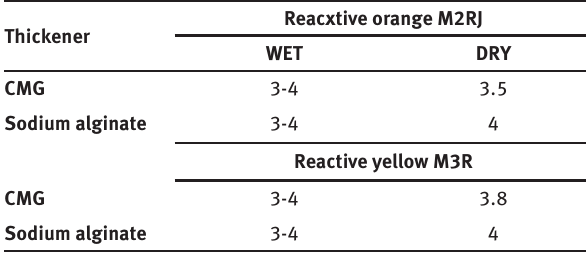
Figure 4: Comparison of CMG thickener with sodium alginate. Table 3: Parameters showing color fastness to crocking for diffe- rent